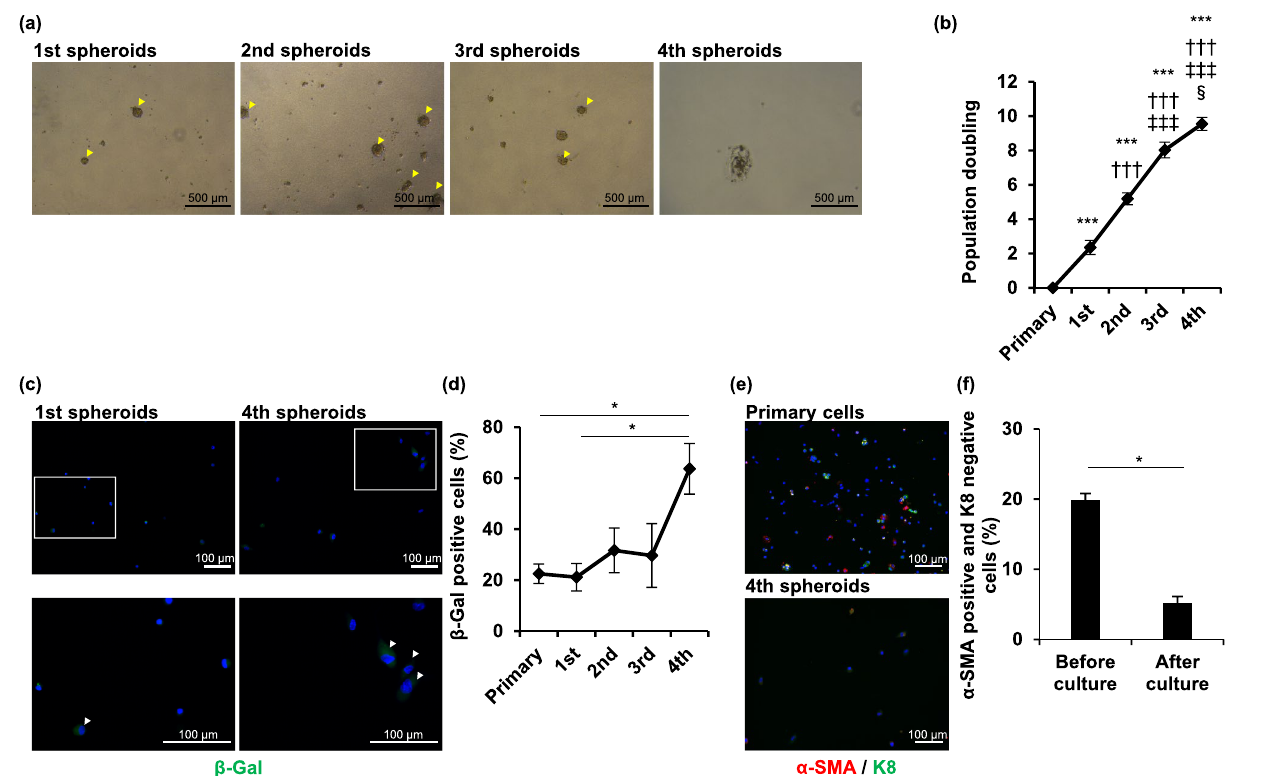
Figure 1. Serially passaged primary sweat gland cells undergo spheroid formation arrest. ( a ) Each image shows sweat gland cell spheroids from the 1st to 4th generation. The cells were cultured in suspension and passaged every seven days. Arrowheads indicate spheroids. ( b ) Growth curves of sweat gland cells derived from five different patients in each generation. Data are presented as the mean ± standard error (S.E.) of five independent experiments (n = 5). § P < 0.05; ***, ††† , ‡‡‡ , P < 0.001 (*,**versus primary, †† versus 1st spheroids, ‡‡ versus 2nd spheroids, § versus 3rd spheroids). ( c ) Images show β-galactosidase (β-gal) staining of cells at the 1st and 4th generation of spheroids. Arrowheads indicate β-gal-positive cells. The bottom panels show magnified views of the areas shown in the upper panels. Nuclei were stained with 4 ′ ,6-diamidino-2-phenylindole (DAPI). ( d ) Rate of β-gal-positive cells derived from spheroids of each generation. At least 50 cells were counted in each experiment. Data are presented as the mean ± S.E. of five independent experiments (n = 5). *P < 0.05. ( e ) Immunofluorescence staining of cells derived from sweat gland tissues (primary cells) and 4th generation spheroids (4th spheroids) for α-smooth muscle actin (α-SMA) (red) and keratin 8 (K8) (green). Nuclei were stained with DAPI. ( f ) Rate of α-SMA-positive and K8-negative cells before and after the culture until spheroid formation arrest. At least 50 cells were counted in each experiment. Data are presented as the mean ± S.E. of